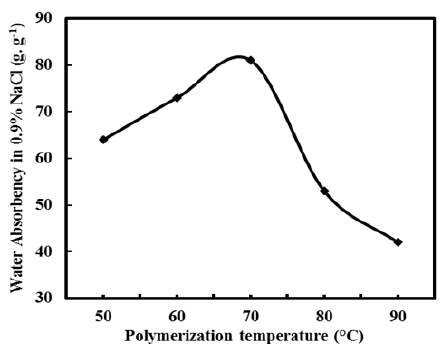
Figure 1. Effect of polymerization temperature on water absorbency of PAA-AM/FA in 0.9% NaCl aqueous solution (mass ratio of AA/AM, 1.5; neutralization degree of AA, 70%; crosslinker concentration, 0.7%; Fly ash (FA) concentration, 50%).